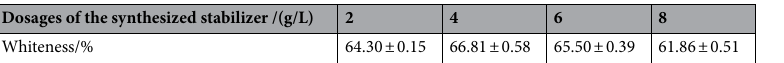
Table 3. The effect of synthesized stabilizer dosage on whiteness.